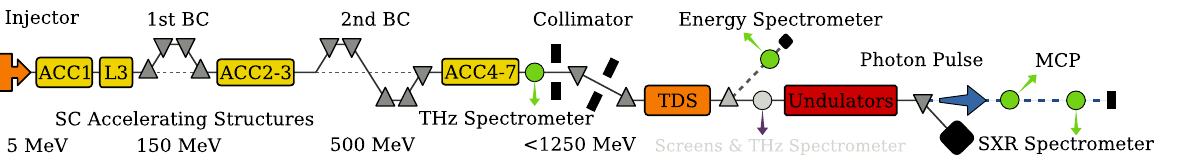
FIG. 1. Layout of the Free-Electron Laser in Hamburg (FLASH) with its superconducting (SC) accelerating structures (ACC), the two magnetic bunch compressor (BC) chicanes, and the new third-harmonic rf linearizer system (L3). The positions of the diagnostics used for photon pulse duration and electron bunch length measurements are indicated by green dots and